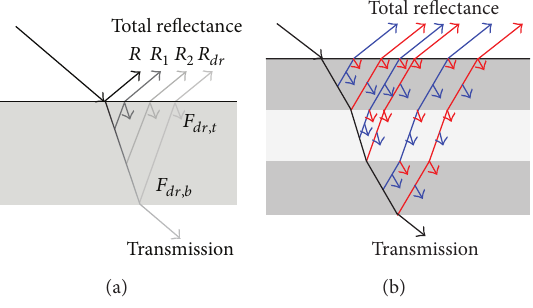
Figure 3: Reflectance and transmission model for (a) single layer and (b) multilayers.